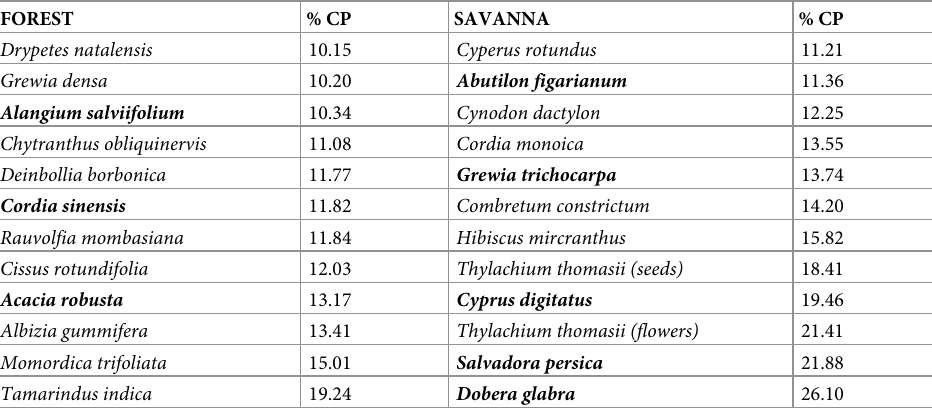
KEY: Food items from top 15 are in bold. Items arranged in ascending CP %